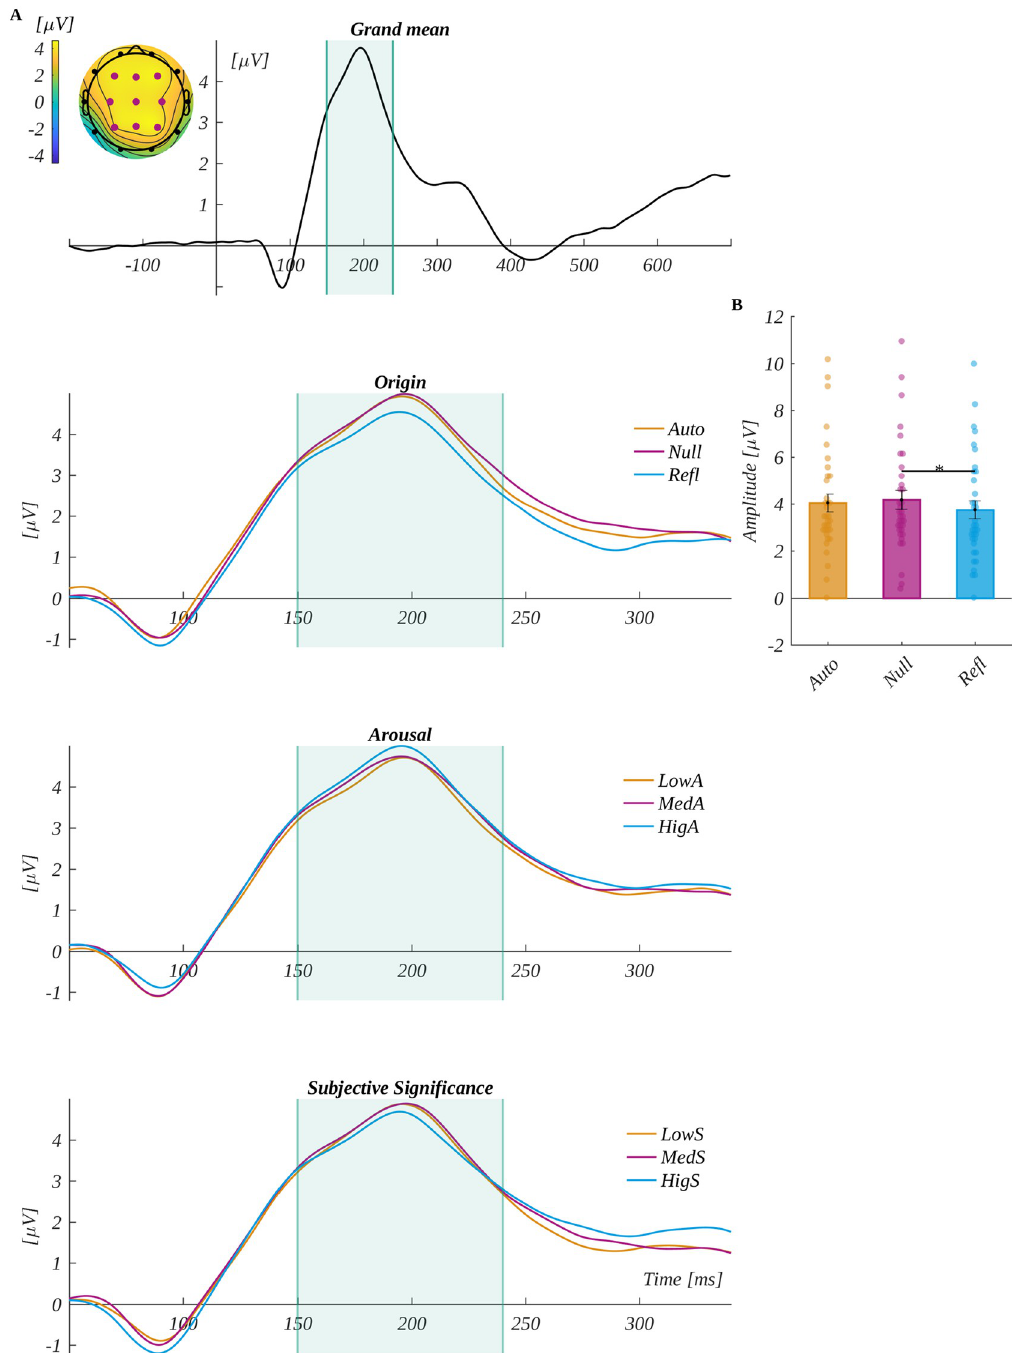
Fig 3. The P2 component results. The upper plot A is the grand average across electrodes from ROI P2 . The marked time- interval was selected for the P2 analysis. The insert shows the topography of the mean potential from this period with the electrodes forming the ROI P2 marked with pink dots. The three bottom plots are the time courses of ERP averaged across electrodes from ROI P2 for each level of origin, arousal and subjective significance. Main effect for: B origin. The bars represent the mean value, error bars SEM, individual dots mark the average amplitude of an individual subject in the given condition, the black horizontal lines indicate pairs of conditions with significantly different means ( � p <